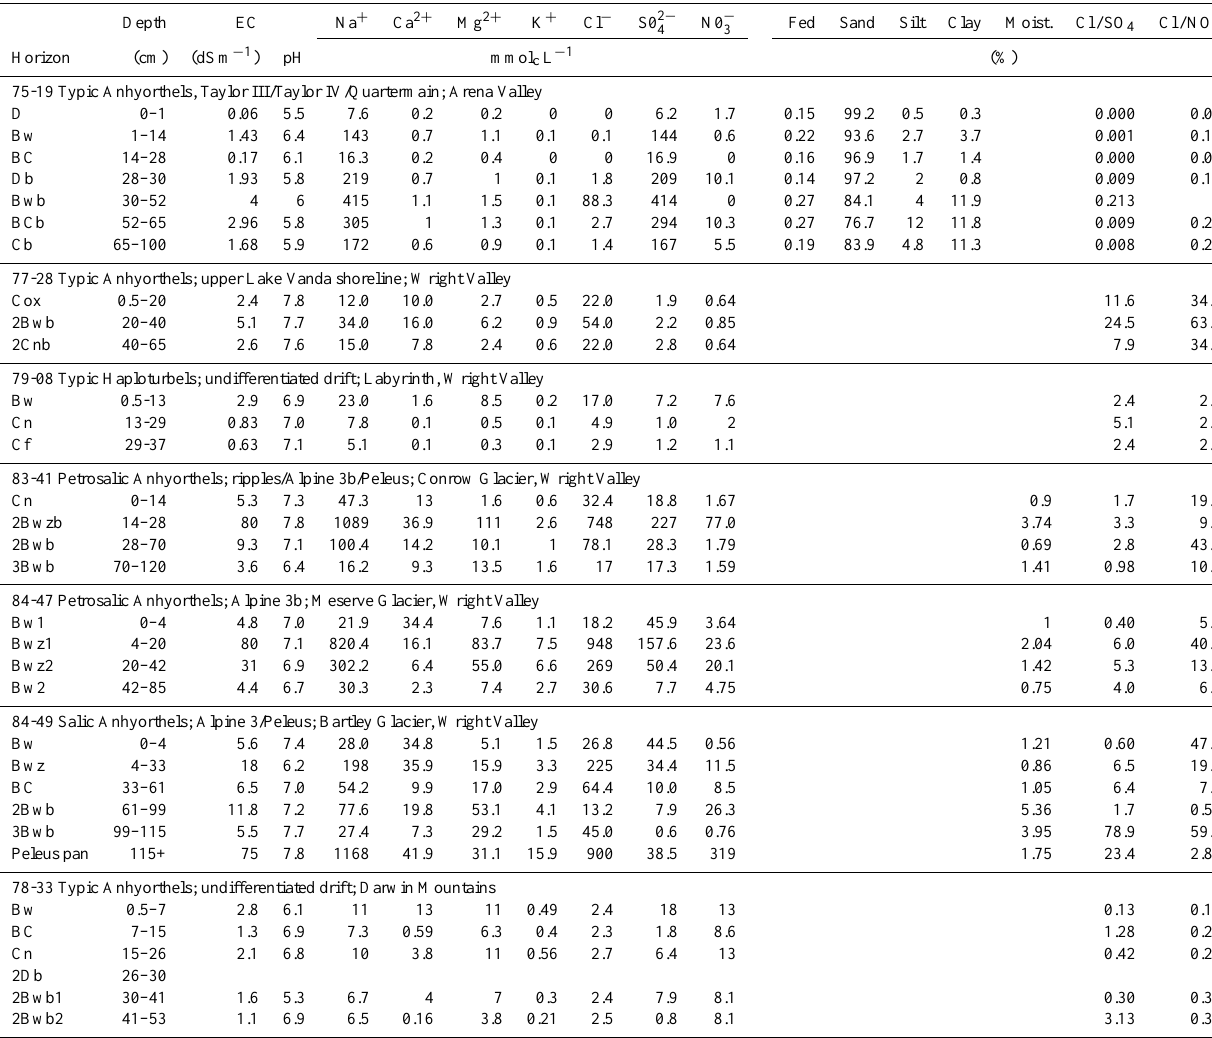
Table 4. Laboratory data for buried soils in the Transantarctic Mountains. Depth EC Na + Ca 2 + Mg 2 + K + Cl − S0 2 − 4 N0 − 3 Fed Sand Silt Clay Moist. Cl/SO 4 Cl/NO 3